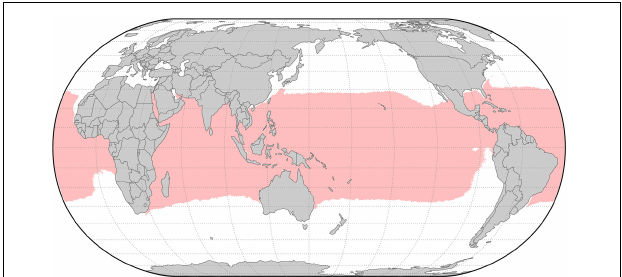
FIGURE 1 | The tropics (shown in red), as defined by a 20 ◦ C isocryme during the coldest period of the year. Anti-tropical taxa are generally distributed on opposite sides of this zone (with Hawai’i as a notable exception), although some authors use latitudinal lines to define anti-tropicality instead of temperatures. Data shown is the SST from the coldest ice-free month from the MARSPEC database (Sbrocco and Barber, 2013) plotted using a Robinson projection in ArcMap v10.8.1